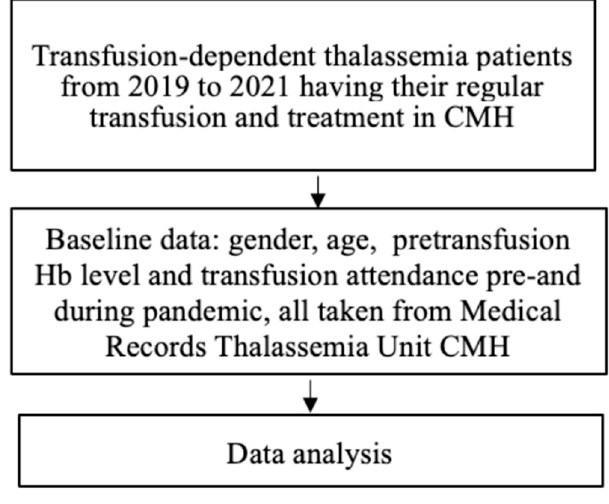
Figure 1. Research